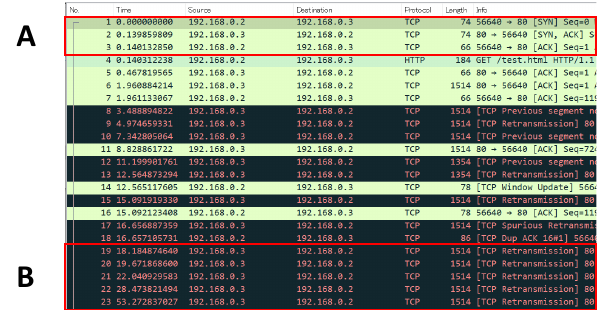
Figure 10. Behavior of TCP communication through file download capture by